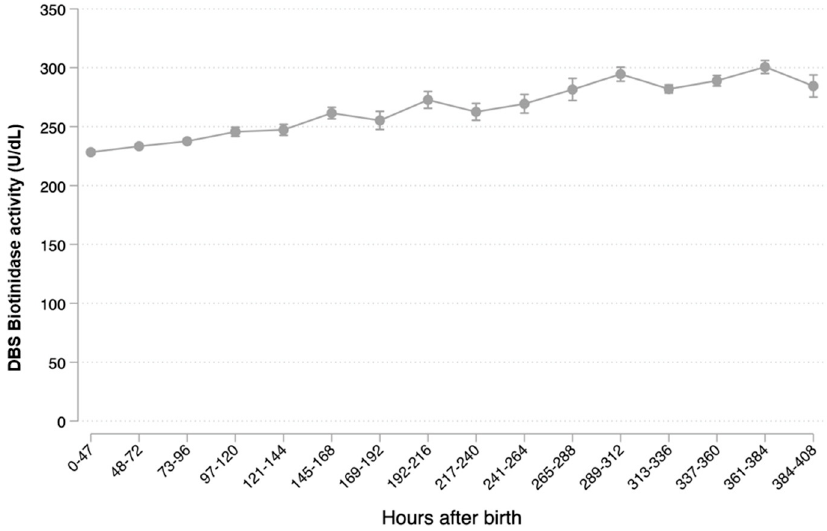
Figure 6. Mean biotinidase activity in DBS vs. the age at specimen collection.